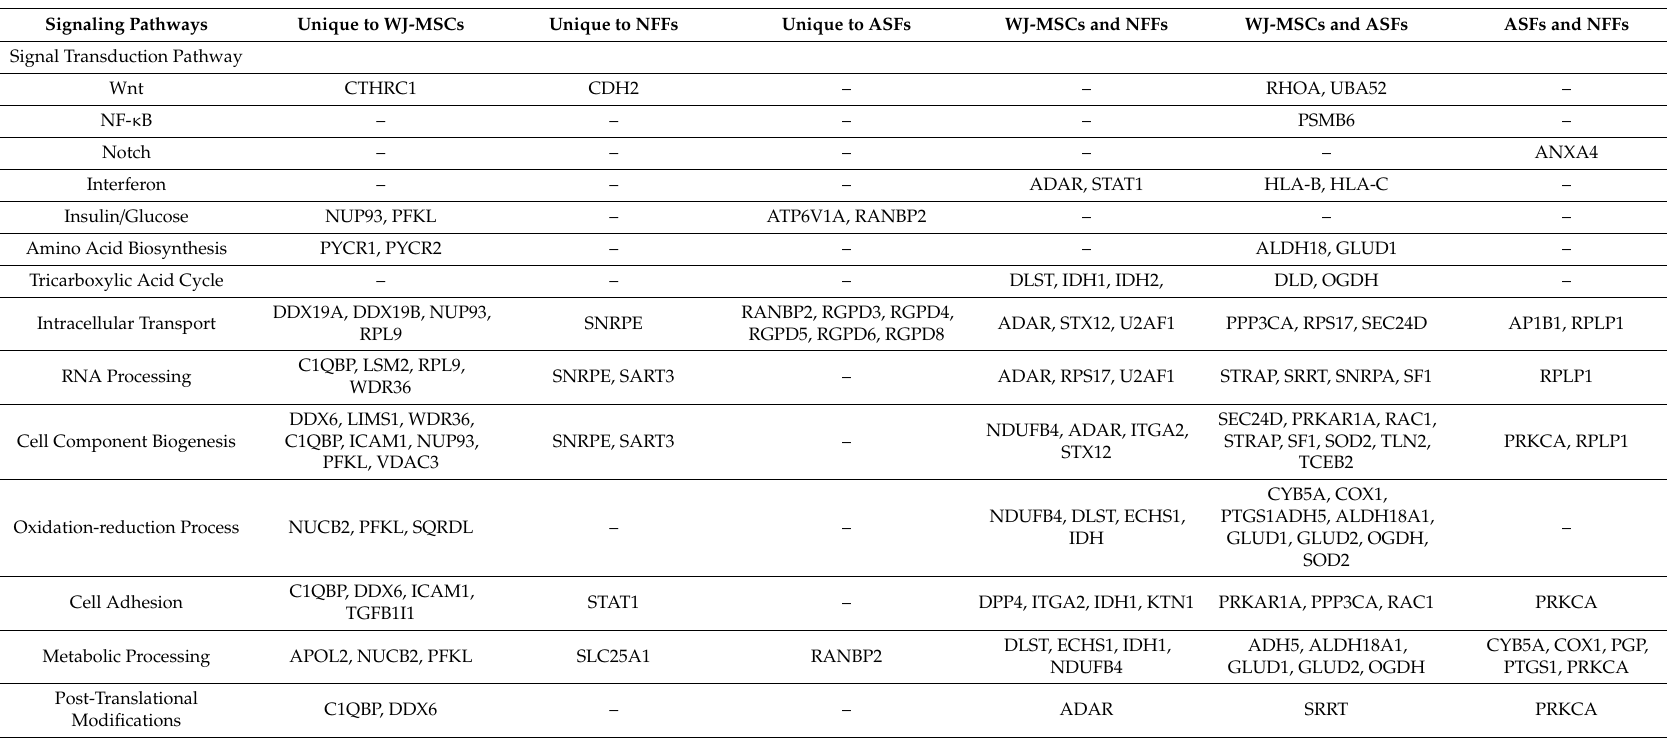
Table 2. Involvement of the identified membrane-bound proteins in signal transduction pathways and biological processes that were di ff erentially by WJ-MSCs, ASFs, and NFFs. − means